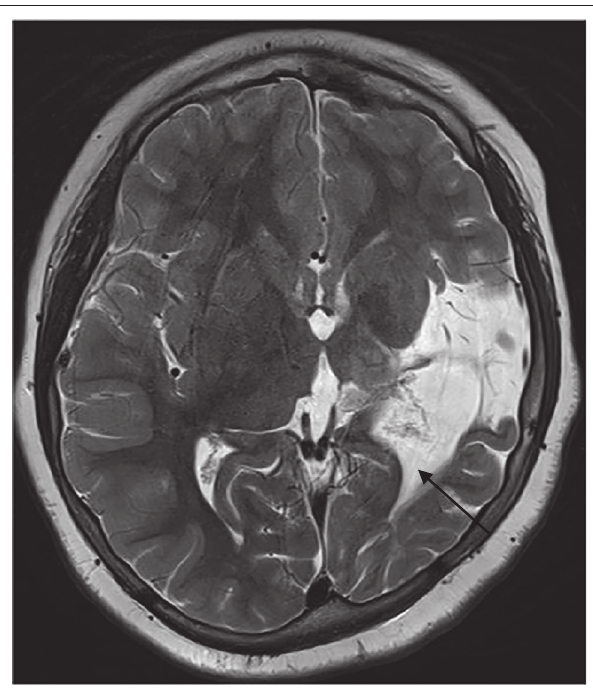
FIGURE 10: Sixteen-year-old girl with history of traumatic head injury 5 years prior to the current study presented with refractory temporal lobe epilepsy. Coronal T2W demonstrates gliosis in the anterior inferior frontal lobes and anterior right temporal pole (arrow). Resection of the anterior right temporal lobe resulted in cessation of her epileptic